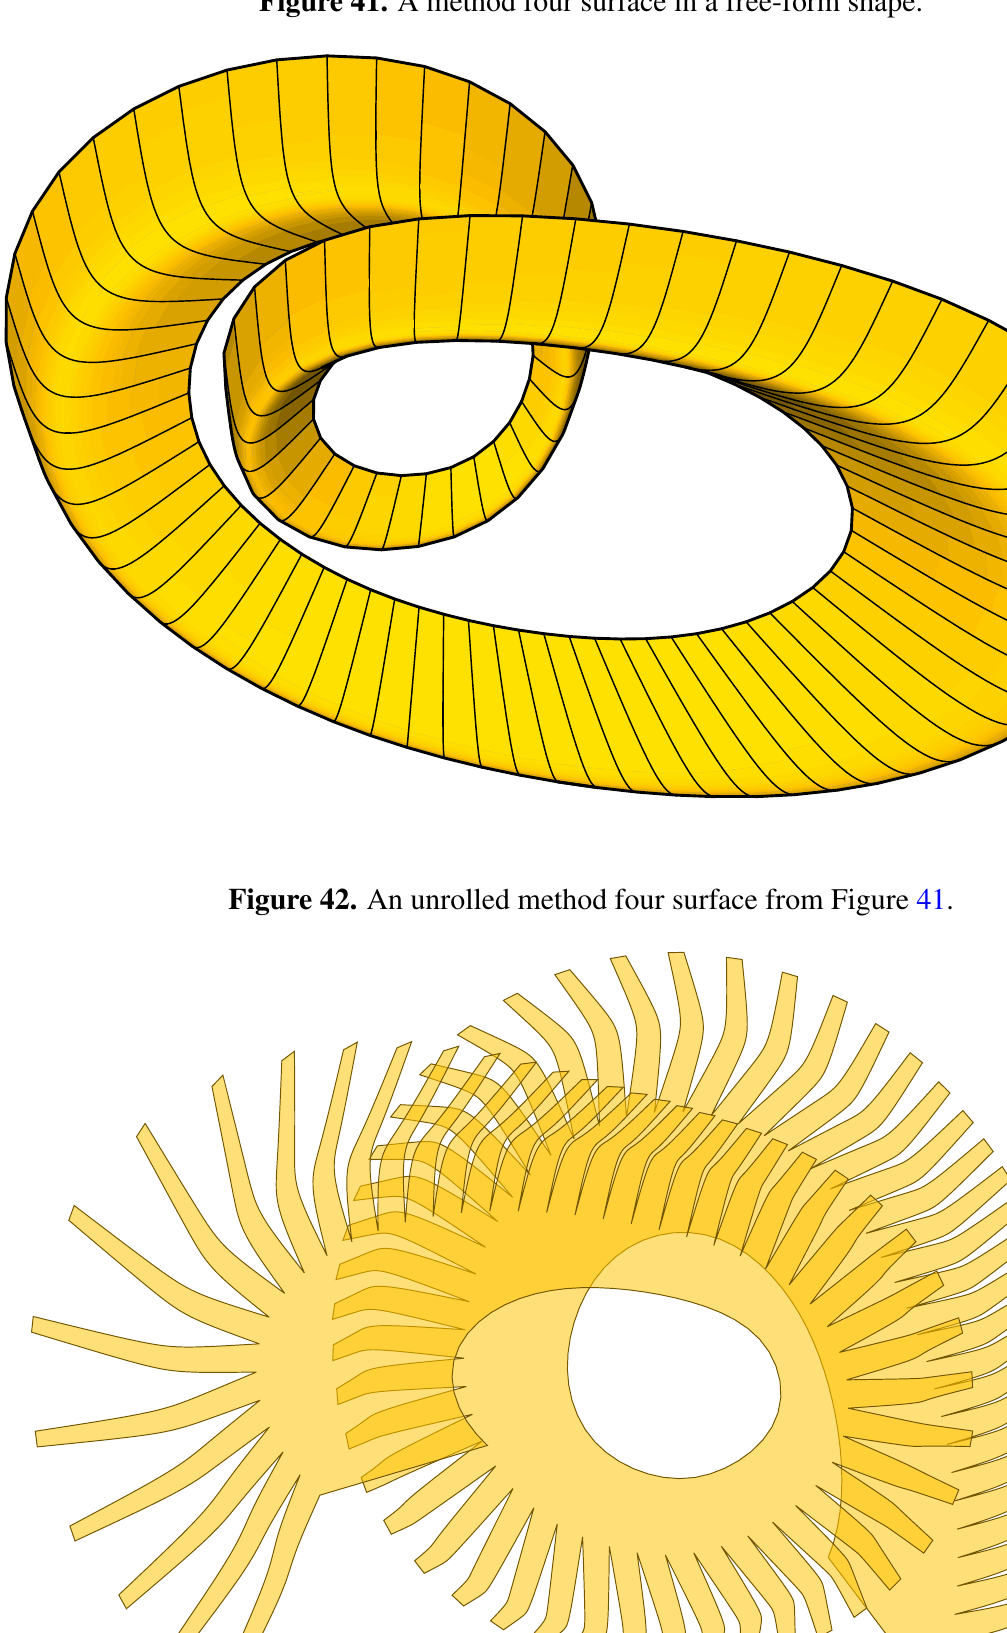
Figure 41. A method four surface in a free-form shape.